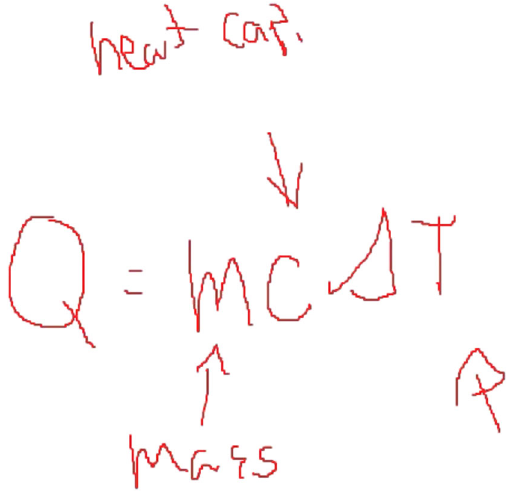
FIG. 7. Fredrik writes down the formula for thermal energy, Q ¼ mC Δ T , but also modifies it by adding arrows and words to v explain it. Fredrik unpacks the representation and highlights different aspects, so that it will be easier to discern the meaning of the formula.